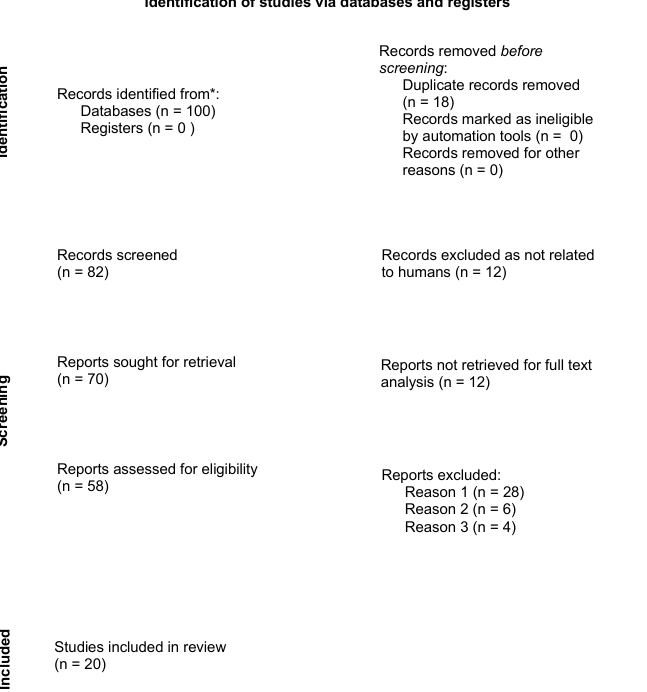
Figure 1. Preferred Reporting items for Systematic Reviews and Meta-Analysis (PRISMA) on novel therapeutic approach to bullous pemphigoid.